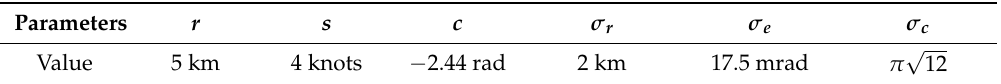
Table 1. The parameters of the tracking.